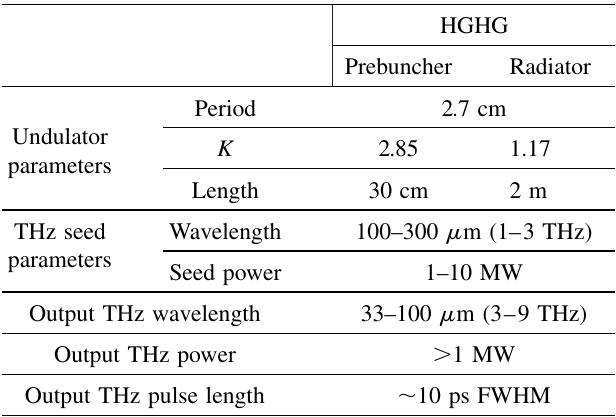
FIG. 12. (Color) Third harmonic output power vs the FEL radiator length with various power: (a) 1 MW; (b) 3 MW; (c) 10 MW of the seed pulse of wavelength 100 (cid:1) m in the pre- buncher. TABLE III. Parameters of the THz HGHG FEL.